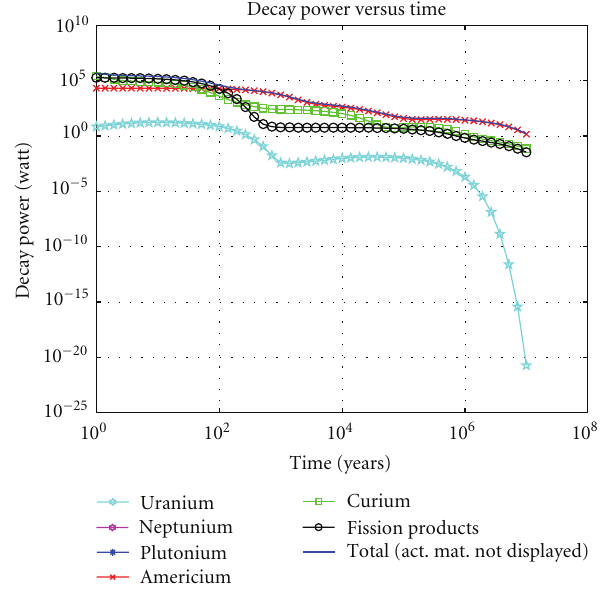
Figure 31: Contributions to heatload versus time—GCFR SNF end sixth